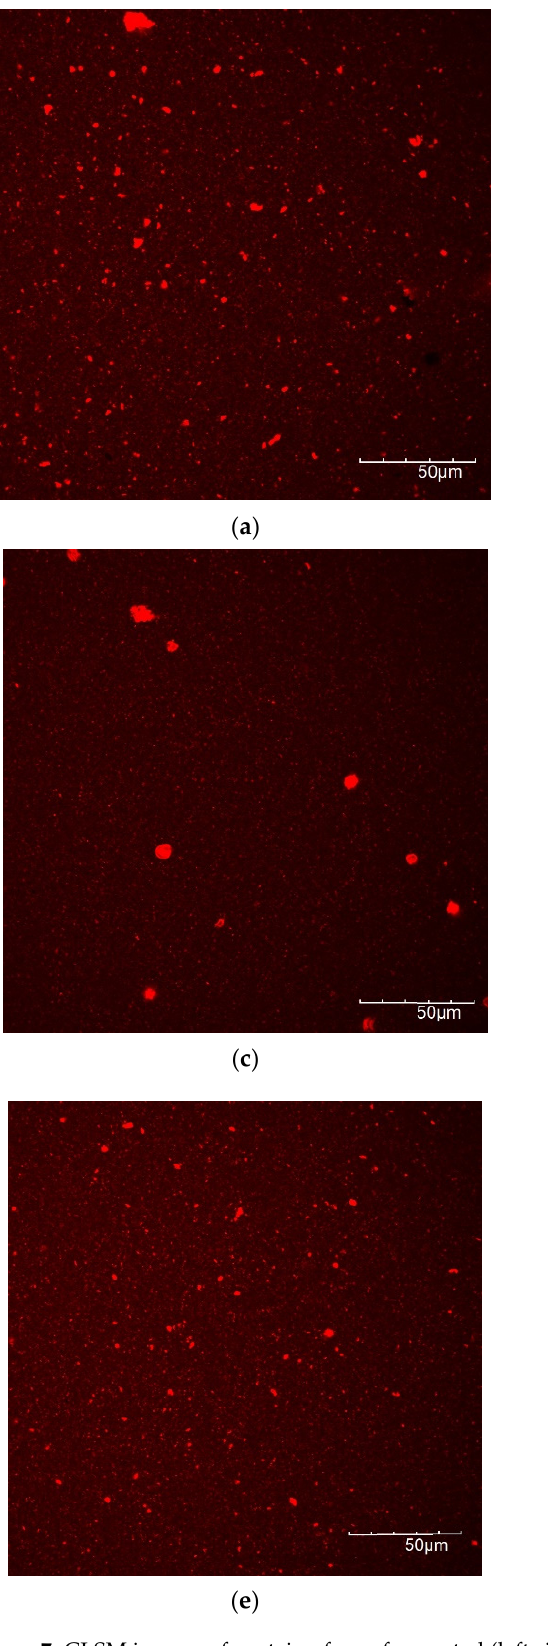
Figure 7. CLSM images of protein of non-fermented (left side) and fermented (right side) samples. ( a , b ) Lentil, ( c , d ) dairy, ( e , f ) soy.